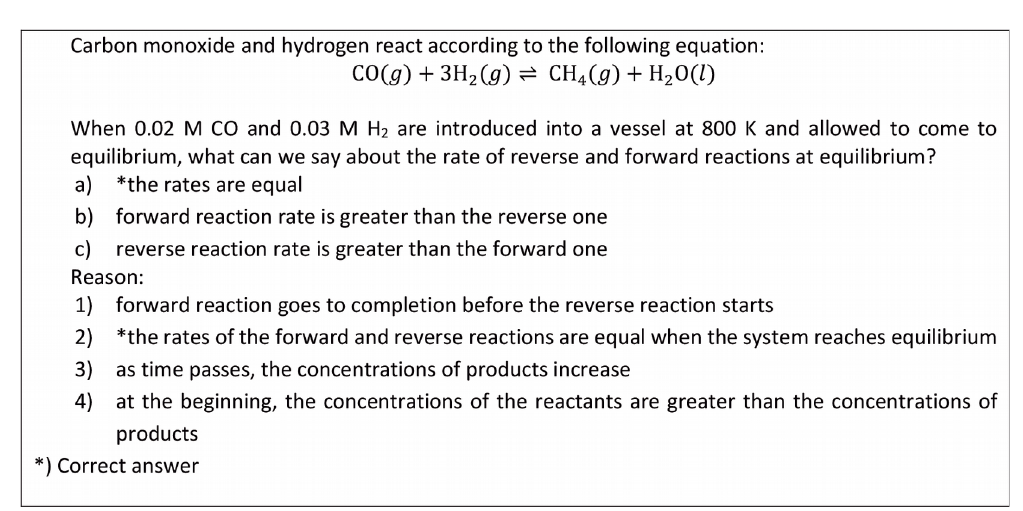
Figure 5. Sample item 3 testing the idea about the equilibrium concept